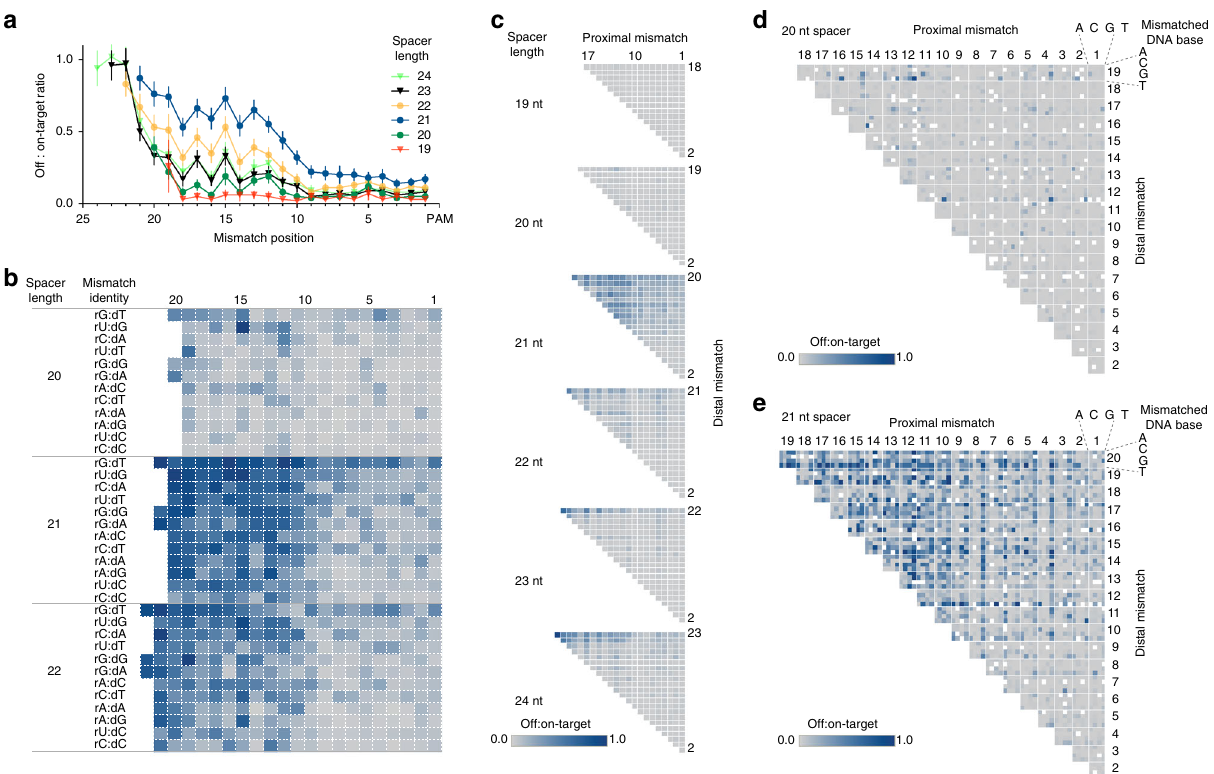
Fig. 2 SaCas9 sgRNA with shorter spacers are less tolerant of mismatches. a Average effect of sgRNA spacer length and mismatch position on SaCas9 single-mismatch tolerance. Mean± 95% con fi dence interval is shown ( n = 16,742 guide-target pairs). b Heatmap of relative SaCas9 cleavage ef fi ciency for each possible RNA:DNA base pair, calculated for all single mismatch library members ( n = 10,344 guide-target pairs). c Heatmap of relative SaCas9 double-mismatch tolerance across different spacer lengths and positions. Data is aggregated from 10 sgRNAs for which all possible single and double mismatches were tested ( n = 28,707 guide-target pairs). d DNA base identity and position effect on double-mismatch tolerance for 20 nt spacer sgRNA ( n = 6017 guide-target pairs) and e for 21 nt spacer sgRNA ( n = 6729 guide-target pairs). All panels use data from Day 3 post-SaCas9